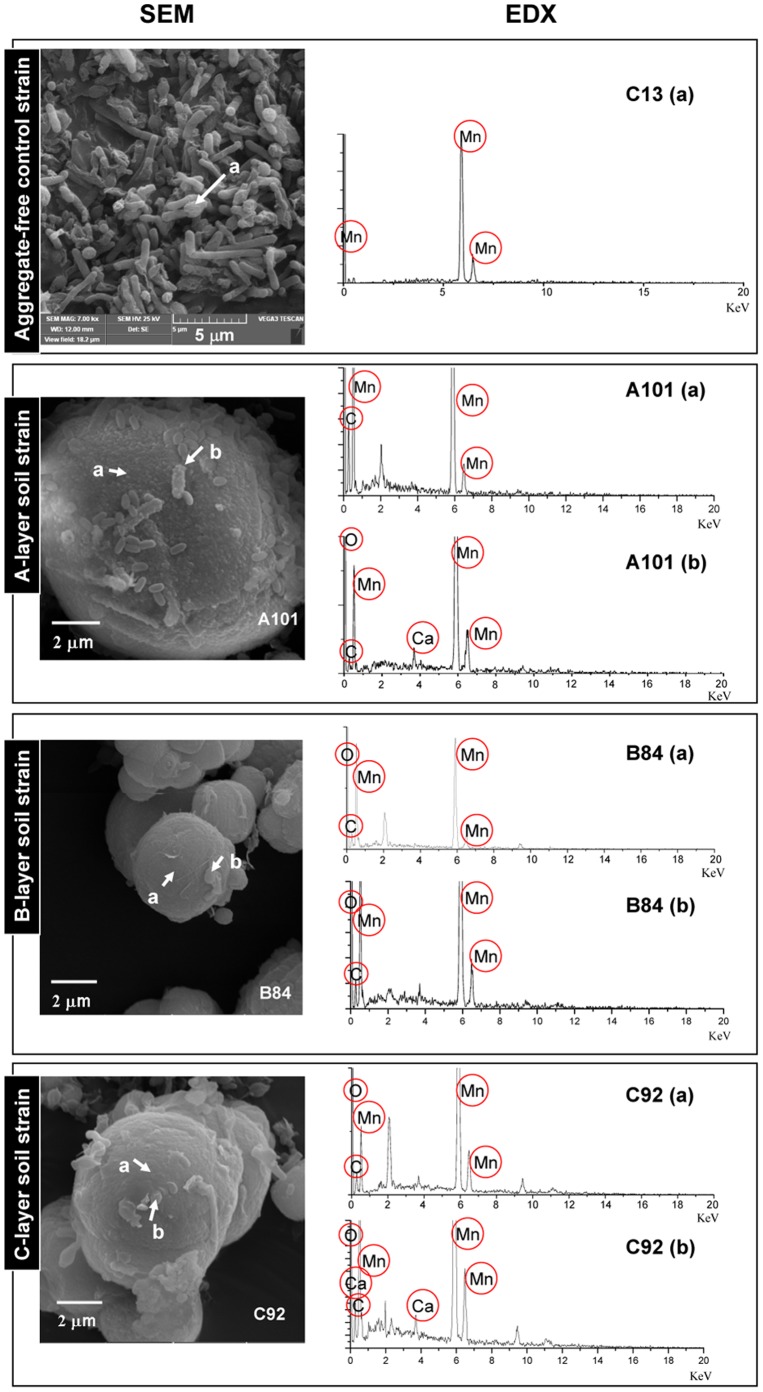
SEM images of the mixture of bacteria and Mn oxides as well as EDX spectra of the selected areas.In SEM, A101, B84, and C92 were the isolates from the A-, B-, and C-layer substrata, respectively, illustrating the formation of Mn oxide aggregates; C13 represents an SEM image of an isolate having no capability to produce Mn oxide aggregates. Two scanning areas for EDX analysis in the SEM images of A101, B84, and C92 were indicated by a, b, and arrows, respectively. A single scan was indicated for C13.